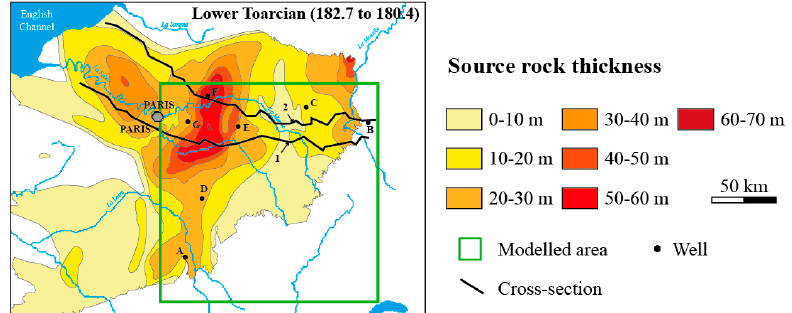
Figure 3. Study area (green square) of the Paris basin and localization of the two cross-sections and of the seven wells used for the calibration of the stratigraphic model. The thickness variations of the Lower Toarcian source rocks (182.7 to 180.4 Ma) are indicated with red to yellow colours. The thicknesses are computed from the cumulative thicknesses of intervals with TOC > 1 wt % (modified after Bessereau et al. [31]; Delmas et al. [32]).